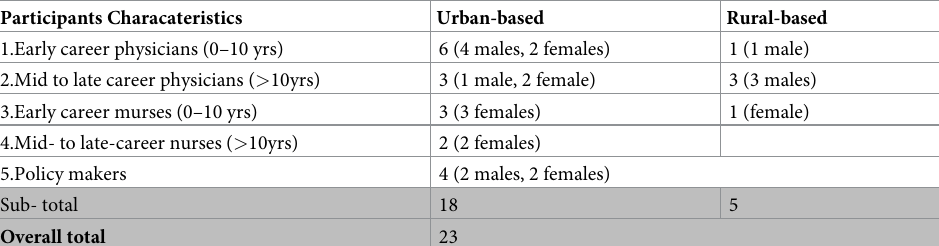
Table 1. Characteristics of selected participants for the